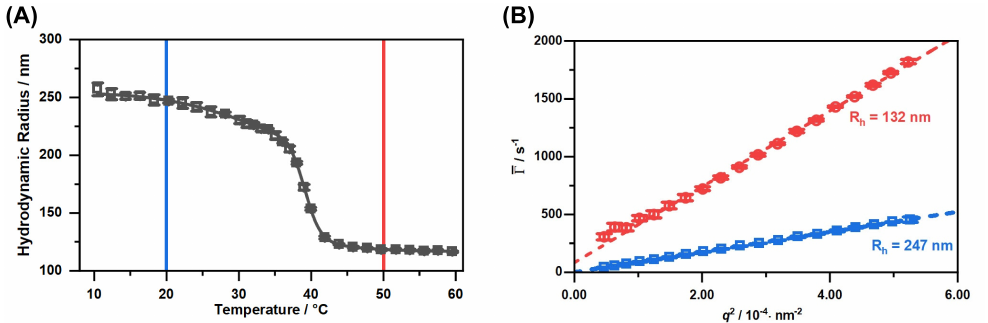
Figure 4. Hydrodynamic radius of the copolymer microgels obtained by temperature-dependent PCS measurements ( A ) and average relaxation rates ¯ Γ plotted against q 2 ( B ) measured with angle- dependent PCS at the temperatures 20°C (blue) and 50°C (red). The straight black line represents a sigmoidal fit through the swelling curve, employed to determine the VPTT of the copolymer microgel by using the point of inflection of the fit. Dotted coloured lines are linear fits used to determine the translational diffusion